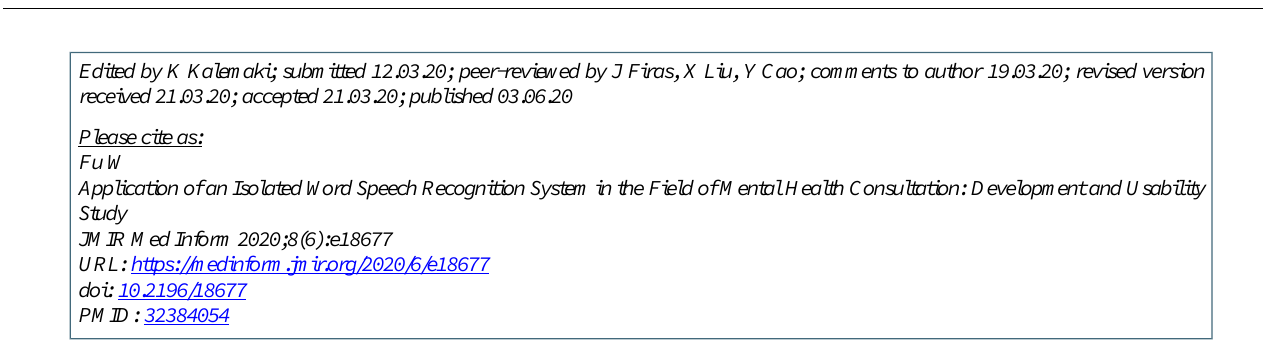
PLCC: Pearson Linear Correlation